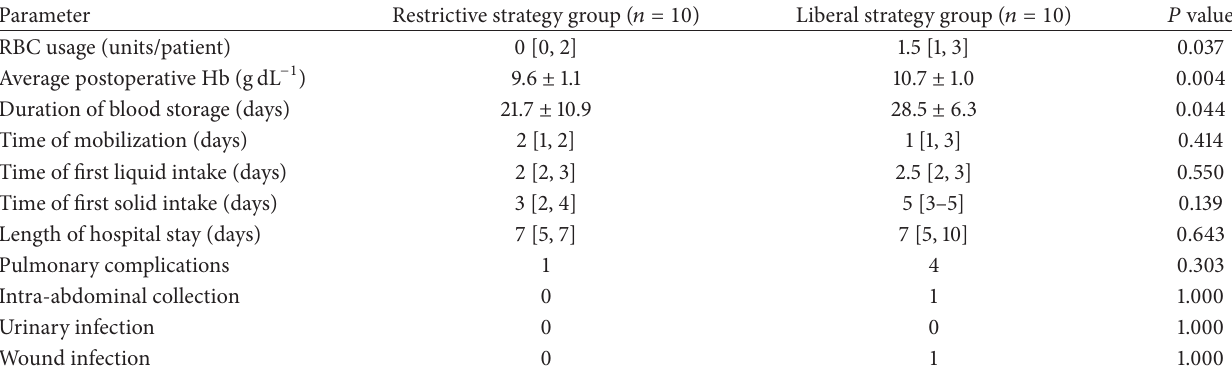
Table 1: Outcome data in the 20 patients of the restrictive and liberal transfusion group who were sampled for perioperative cytokines.